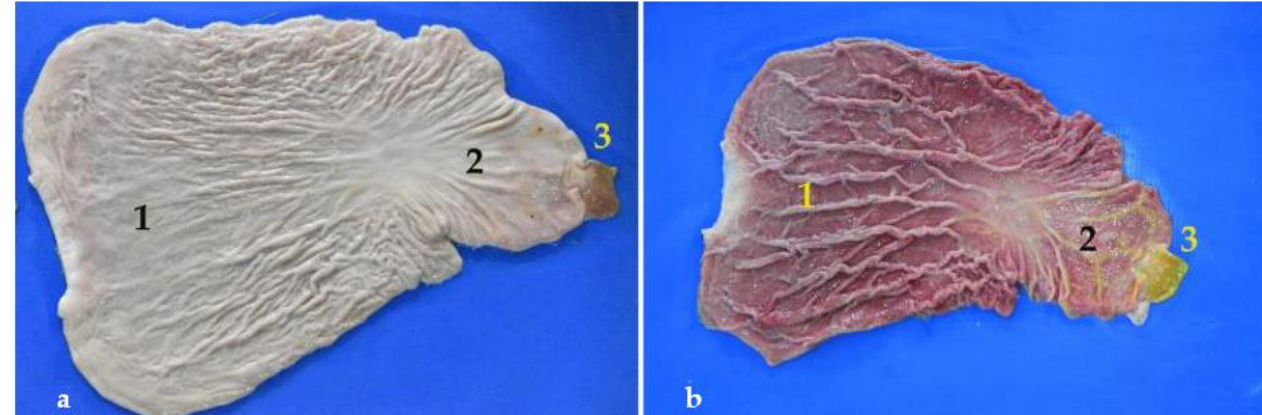
Figure 9. ( a , b ) Open stomach. Note the numerous folds of the mucosa. In ( a ) the stomach has been washed with water for days. ( 1 ) Fundic part; ( 2 ) pyloric part; ( 3 ) pylorus. The stomach shows two curvatures: lesser and greater. First, the lesser curvature is straight and vertical, and forms the angular incisure, just at the bottom. This incisura is the consequence of a sudden change in direction of the pyloric part, which is directed cranio- dorsally (Figure 8). According to our results, the average length of the lesser curvature in juveniles is 20 cm, just half of that in adults, where it is 41 cm. On the opposite side is the greater curvature, which is considerably larger, with a length of 62 cm in adults and 38 cm in juveniles. Interestingly, in the South American fur seal, the greater curvature is not even double than the lesser (Table